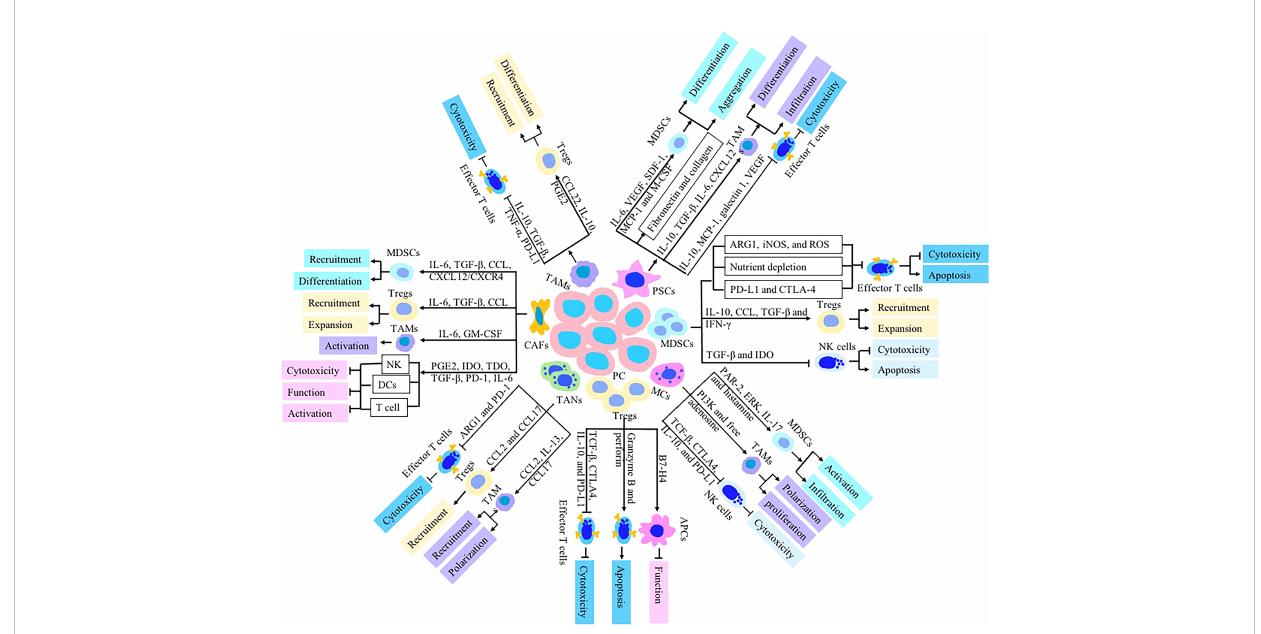
FIGURE 1 Immunologic effects of stromal cells including MDSCs, CAFs, TAMs, PSCs, Tregs, TANs and MCs on pancreatic TME. These stromal cells dysregulate the function of immune cells-mediated antitumor immunity to establish an immunosuppressive TME via secretion of chemokines and cytokines such as TGF- b , IL-10, IL-35, CCL5, CXCL12, GM-CSF, PGE2, IDO, PD-L1 and CTLA-4. The cytotoxic activity and cytokines production of NK cells, DCs and CTLs are inhibited in pancreatic